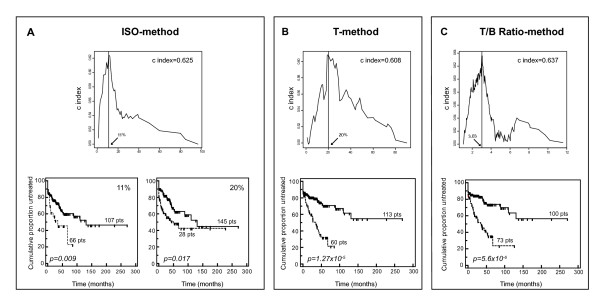
C index and Kaplan-Meier curves for ZAP-70 evaluation according to ISO-, T- and T/B Ratio-methods (test set). Upper panels in A, B, and C show c index curves applied to ZAP-70 expression values to estimate the optimal cut-off capable to split patients into groups with different time to treatment (TTT) probabilities. X-axes report expression values for ZAP-70, expressed as percent of positive cells (A and B), or T/B ratio values (C); y-axes report the corresponding c index values. For each method, solid line indicates the chosen cut-off value. Lower panels show Kaplan-Meier curves obtained comparing TTT of patients affected by CLL expressing or not ZAP-70, as evaluated according to ISO- (A), T- (B) or T/B Ratio- (C) methods. In all plots, solid lines indicate ZAP-70 negative CLL, while dashed line indicate ZAP-70 positive CLL, according to the three readouts. In (A) Kaplan-Meier curves obtained by dividing CLL patients according to two different cut-offs (11% and 20%) for ZAP-70 evaluation are reported.